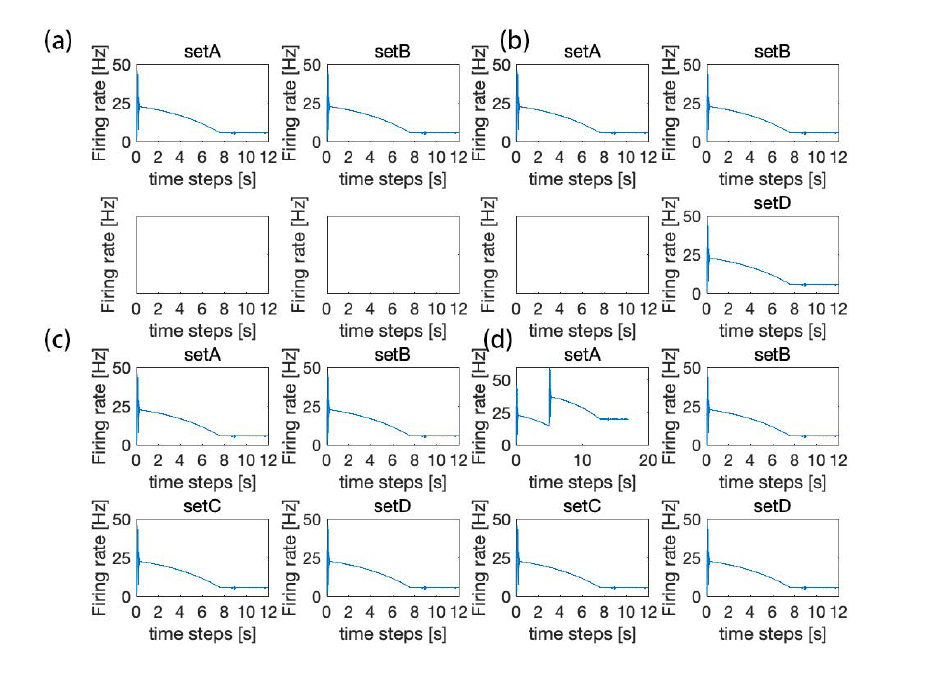
Figure 12. Memory update. If there is a free set ( a ), SDN chooses the free set to store new memory ( b ). If there is no free set ( c ), SDN updates the set that has the lowest firing rate in the SDN ( d